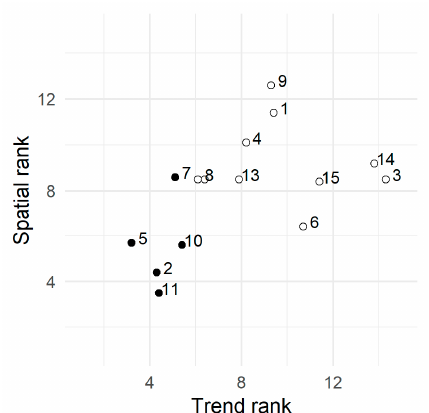
Figure 4. Average ranks for RCP 4.5 and 8.5 according to KGE, APB, and RMSE. Numbers correspond to the model ids in Table 3. The lower the rank, the better the model performance. Selected climate models for the ensemble subset in black.